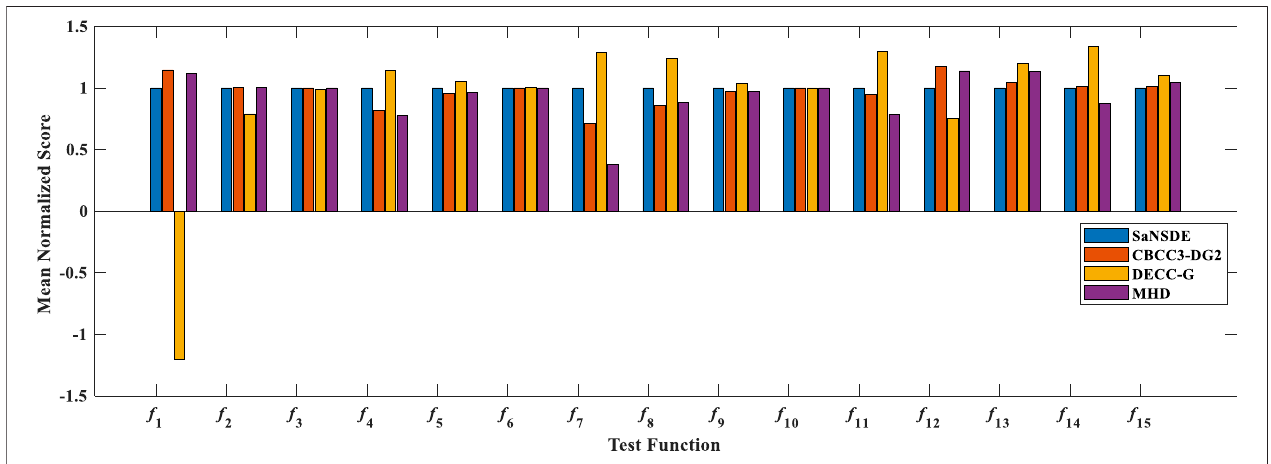
FIGURE 3 | The mean normalized scores of the four algorithms. The lower the value indicates a better performance.